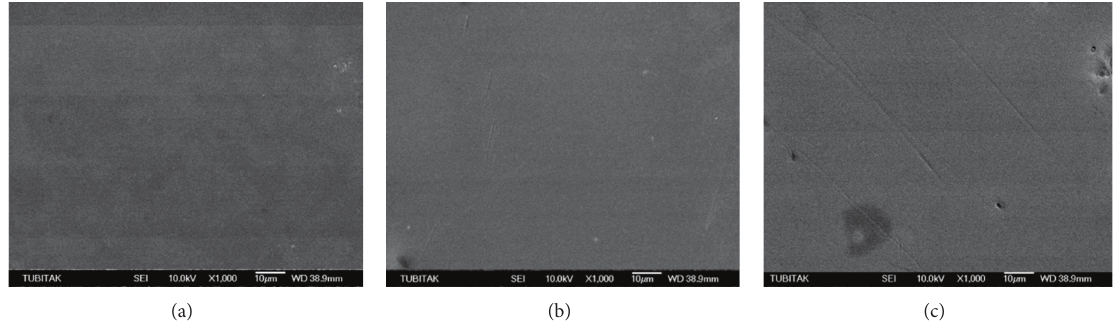
Figure 6: (a, b) Scanning electron micrographs of GEE-C and GEE-DT groups revealed similar homogeneous surfaces while some defects were evident in GEE-TP group